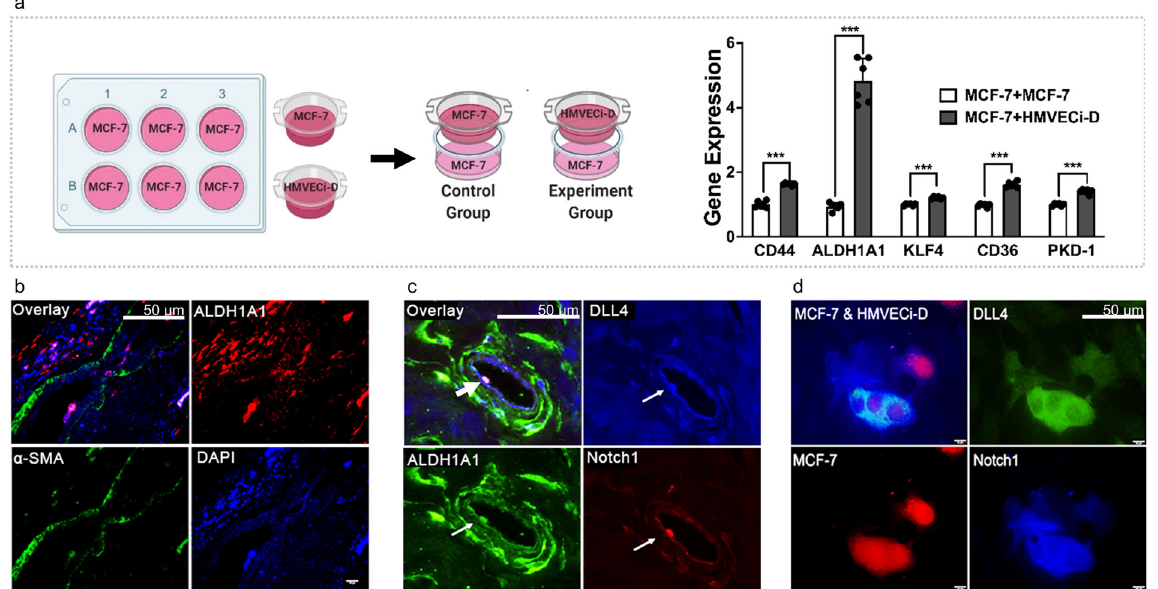
Fig. 2 Indirect and direct interactions of breast cancer stem-like cells with the arteriolar endothelium within TME. a Coculture of breast cancer cells and endothelial cells increased the expression of BCSC markers and stemness-associated genes. Total RNA in MCF-7 cells cultured in a six-well plate was collected for detection of stemness-associated genes at mRNA levels by RT-qPCR. The results of triplicate experiments are shown as mean ± SEM. *** P < 0.001, ** P < 0.01, or * P < 0.05 compared with the control. b An ALDH1A1 + BCSC was attached to the arteriolar endothelium within the vascular lumen. The human BC specimen was stained with ALDH1A1 and alpha-smooth muscle actin ( α -SMA) antibodies used, followed by appropriate secondary antibodies and mounted with DAPI. Scale bar = 50 µ m. c An ALDH1A1 + cell that expresses high levels of Notch1 and DLL4 interacts with DLL4 + endothelium in the arteriolar vessel. Human breast cancer specimens were processed and stained with Notch1, DLL4, and ALDH1A1 antibodies followed by appropriate secondary antibodies. Scale bar = 50 µ m. d MCF-7 cells transduced with DsRed interacted with an HMVEC. MCF-7 cells transduced with Ds- Red that were grown in complete MammoCult ™ Media for 5 days were cocultured with HMVECi-Ds that expressed with DLL4 at the ratio of 2:1 in DMEM for 48 h. The cells were stained with Notch1 and DLL4 antibodies, followed by appropriate secondary fl uorescence antibodies. Scale bar = 50 µ m. The images were taken with an Olympus BX60 fl uorescence microscope, and representative images are